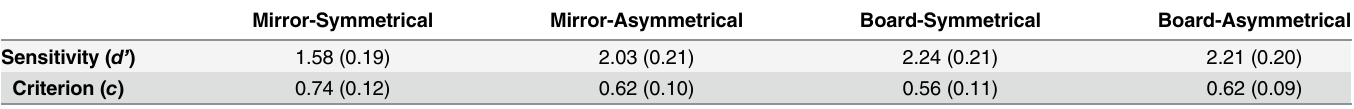
Table 1. Mean sensitivity and criterion data across the four experimental conditions.